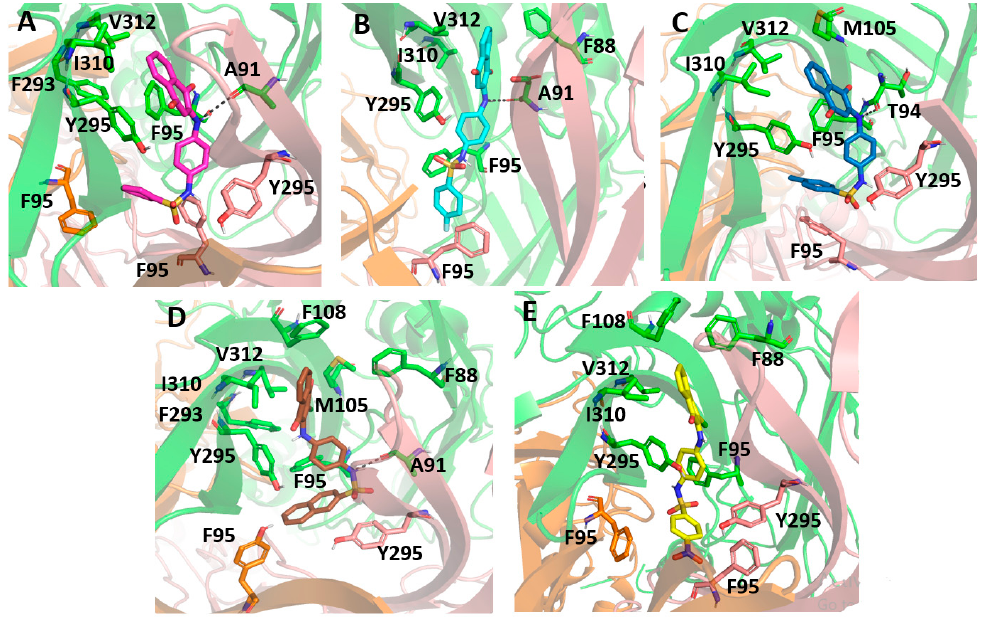
Figure 9. Molecular docking of the sulfonamide derivatives into the P2X7 allosteric pocket. The P2X7R is depicted in cartoon and the main residue involved in the interaction is depicted in stick ( A ) In pink is represented the PS01 ( B ) In cyan is represented the PS02 ( C ) In dark blue is represented the PS03 ( D ) In brown is represented the PS09 ( E ) In yellow is represented the PS10. The binding free energy indicated that sulfonamides had an affinity for the P2X7